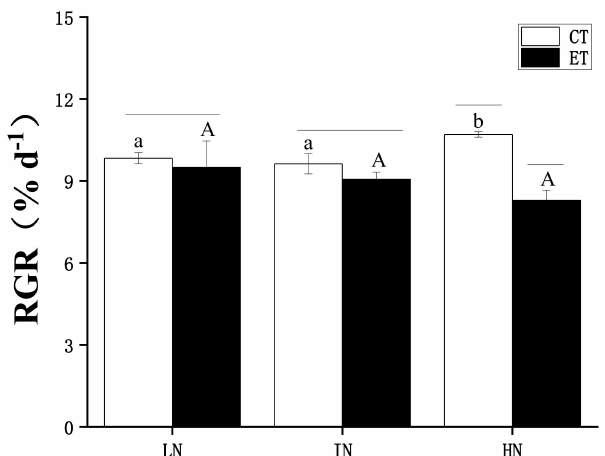
Figure 1. Relative growth rate (RGR) of Sargassum horneri under low nitrogen (LN), intermediate N (IN), and high N (HN) treated by ambient temperature (CT) and elevated temperature (ET) during the experiment. Data are means ± SD (n = 3). Horizontal lines represent significant differences ( p < 0.05) among the temperature levels at the same N concentration, the different capital letters represent significant differences ( p < 0.05) among N concentrations at the elevated temperature, while the different lower-case letters represent significant differences ( p < 0.05) among N concentrations at the ambient